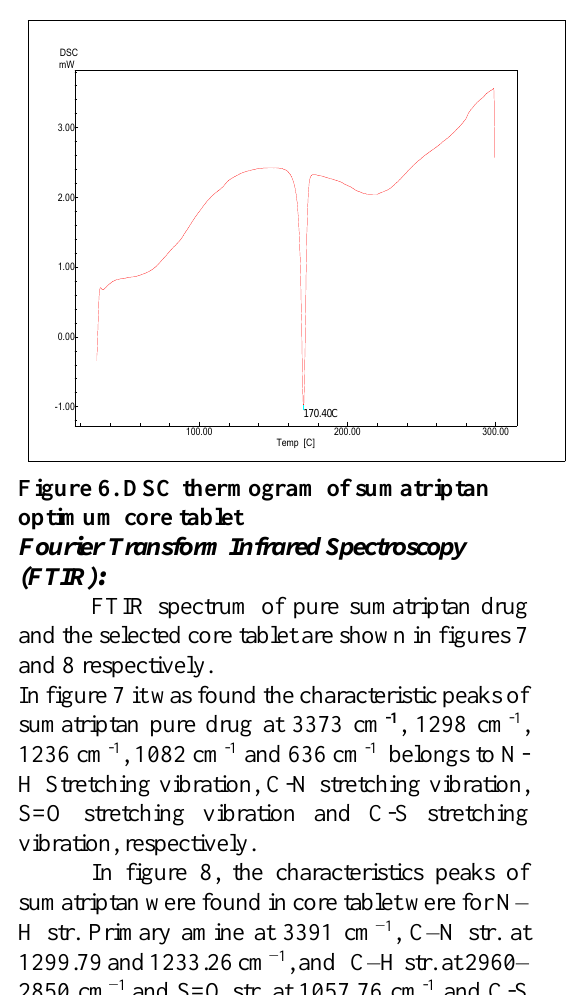
Figure 4. DSC thermogram of pure